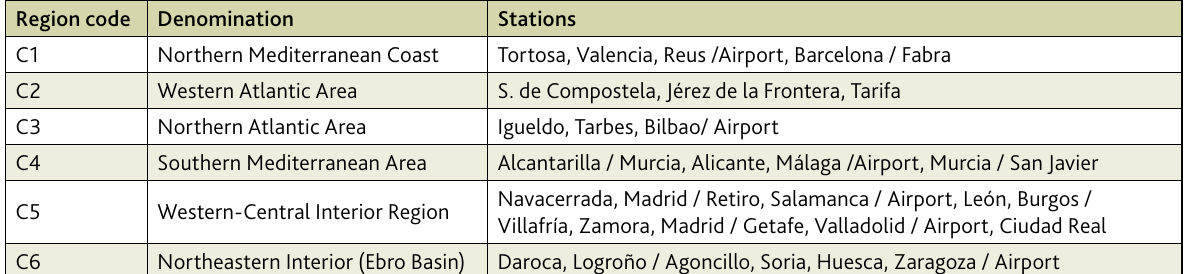
Table 2. Climate regions proposed by the Climatol clustering process for the analyzed weather stations. Region code